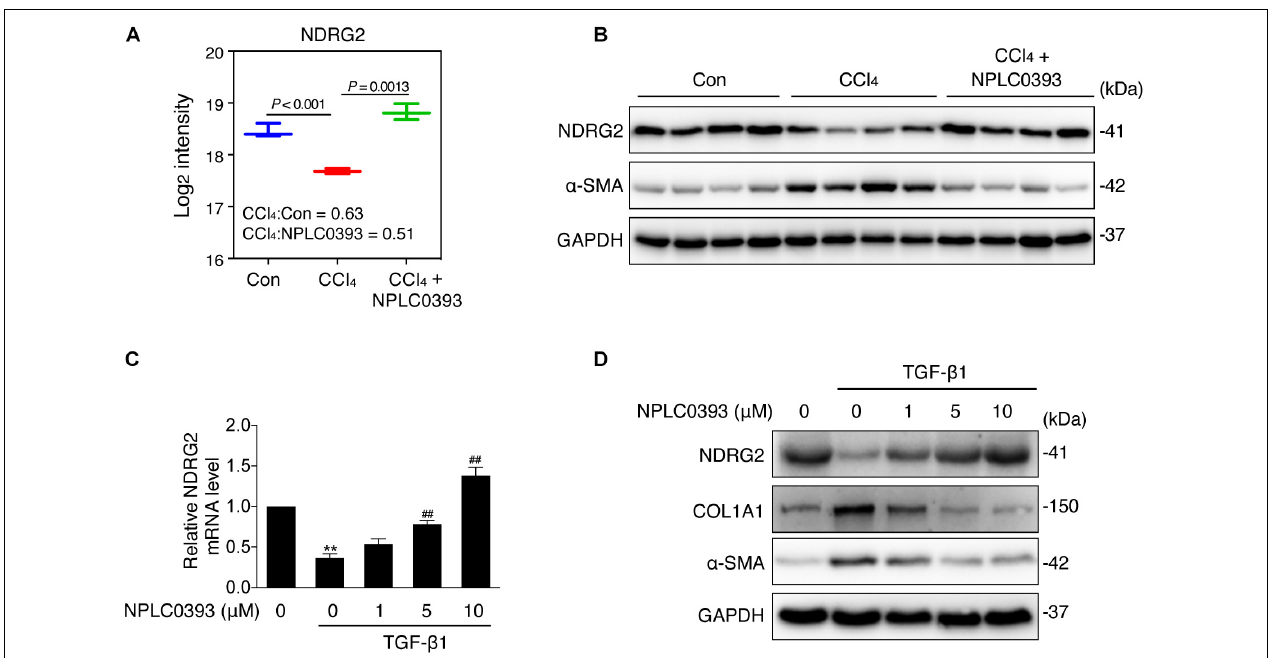
FIGURE 3 | Effect of NPLC0393 on the expression level of NDRG2. (A) Boxplot showing the log2 transformed intensity of NDRG2, as quantified by LC-MS/MS. (B) Western blot of NDRG2 ( ∼ 41 KD) and α -SMA protein expression in all tissue samples ( n = 4 per group). GAPDH was used as the loading control. (C) LX-2 cells were treated with increasing concentrations (1, 5, and 10 µ M) of NPLC0393 for 24 h and stimulated with 10 ng/mL TGF- β 1 for another 24 h. Relative mRNA levels of NDRG2 were analyzed by qRT-PCR. ** P < 0.01 compared with the control group; ## P < 0.01 compared with the TGF- β 1 treatment group, as analyzed by one-way ANOVA followed by Dunnett’s test. (D) Representative western blot of NDRG2, α -SMA and COL1A1 protein expression in LX-2 cells treated as in (C) .